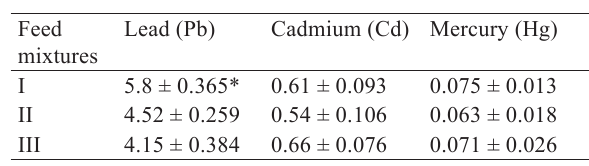
Table 4 Heavy metal levels in commercial feed mixtures consumed by farmed rainbow trout in three different aquaculture sites